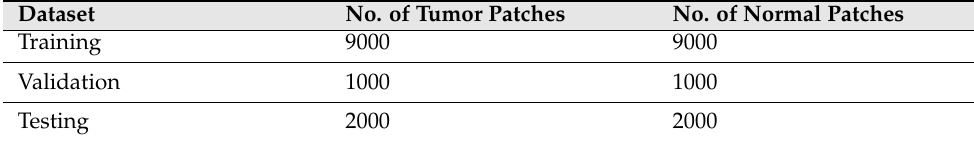
Table 11. Distribution of Patches in the Training, Validation, and Testing Sets.